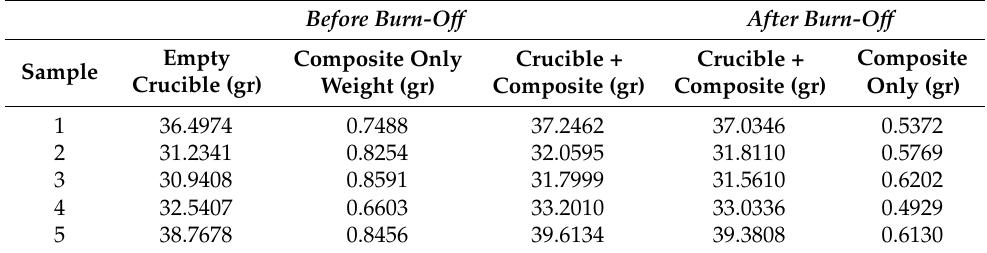
Table A1. Crucible and composite weights before and after burn-off (gr). Before Burn-Off After Burn-Off Empty Composite Composite Only Crucible + Crucible + Sample Crucible (gr) Only (gr) Weight (gr) Composite (gr) Composite (gr)